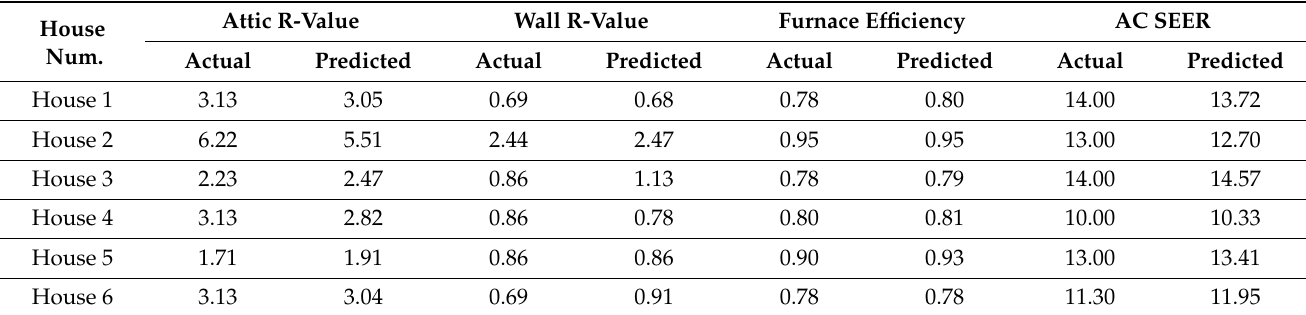
Table 8. Actual and predicted data for the testing houses with using thermostat-derived information.